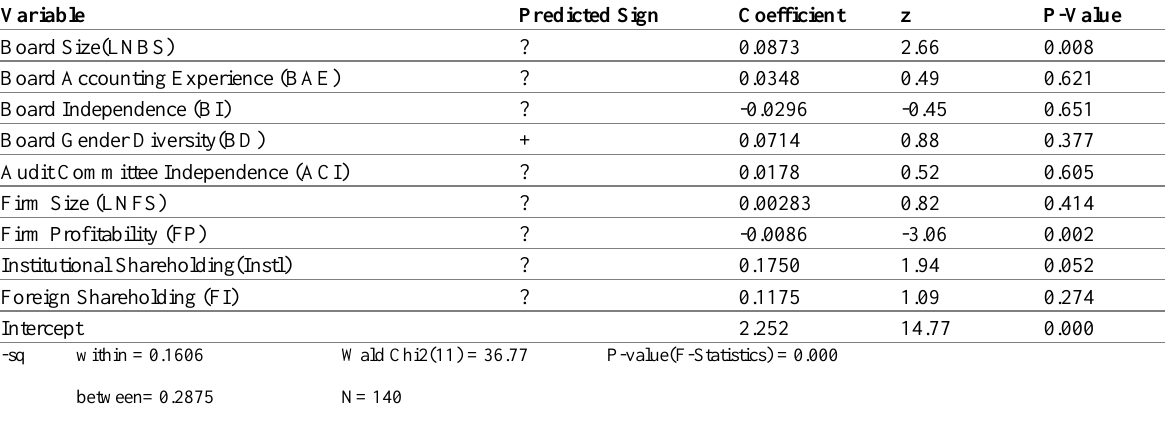
Table 5: Multiple Linear regression results- Random Effect